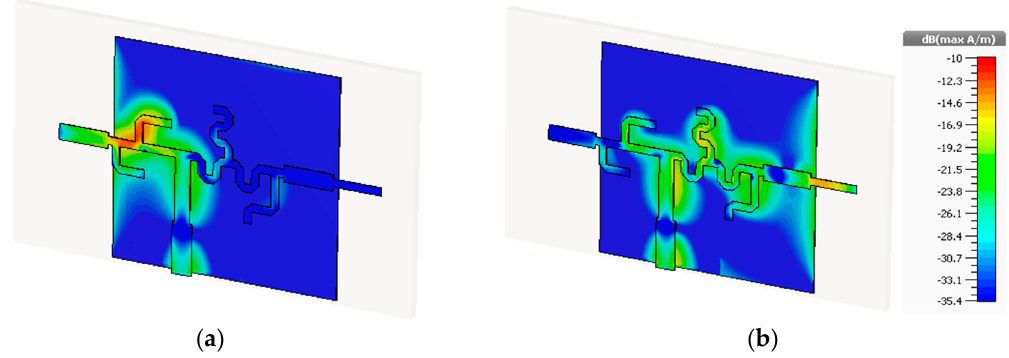
Figure 11. Surface Current Distribution at ( a ) 28 GHz and ( b ) 38 GHz.